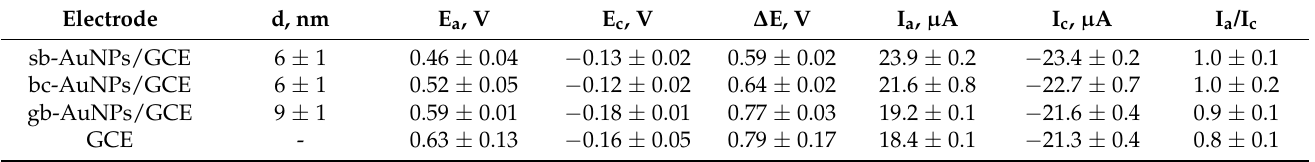
Figure 8. Cyclic voltammograms of 5.0 mM [Fe(CN) 6 ] 3 − /4 − in 0.1 M KCl on GCE ( a ) and GCE modified with gold nanoparticles obtained by using 1.0 mL extract of gooseberry ( b ), 1.0 mL extract of black currant ( c ), and 0.75 mL extract of strawberry ( d ) leaves. pH of all extracts: 12. Potential scan rate: 0.05 Vs − 1 . Table 4. Parameters of electrochemical transformation of 5.0 mM [Fe(CN) 6 ] 3 − /4 − in 0.1 M KCl on GCE and phyto-AuNPs/GCE. Conditions of phyto-AuNPs synthesis: C(HAuCl 4 ) = 1 mM, V extr = 0.75 mL (for sb-AuNPs), V extr = 1.0 mL (for bc-AuNPs and gb-AuNPs), and pH of all extracts: